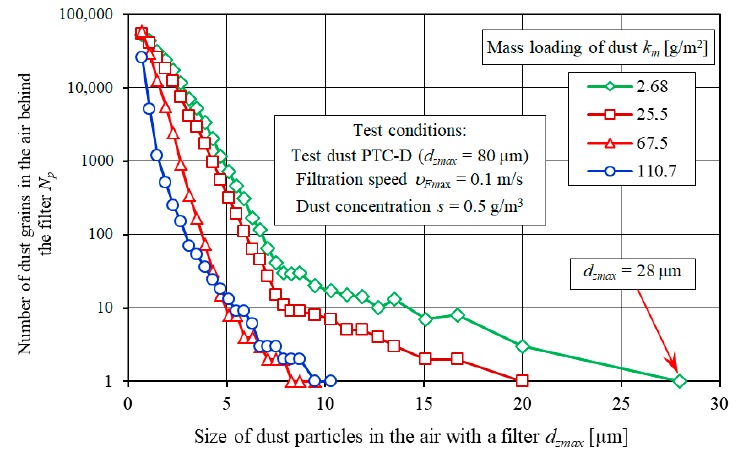
Figure 9. The number of dust particles in subsequent measuring intervals in the air downstream of the filter element A (cellulose).